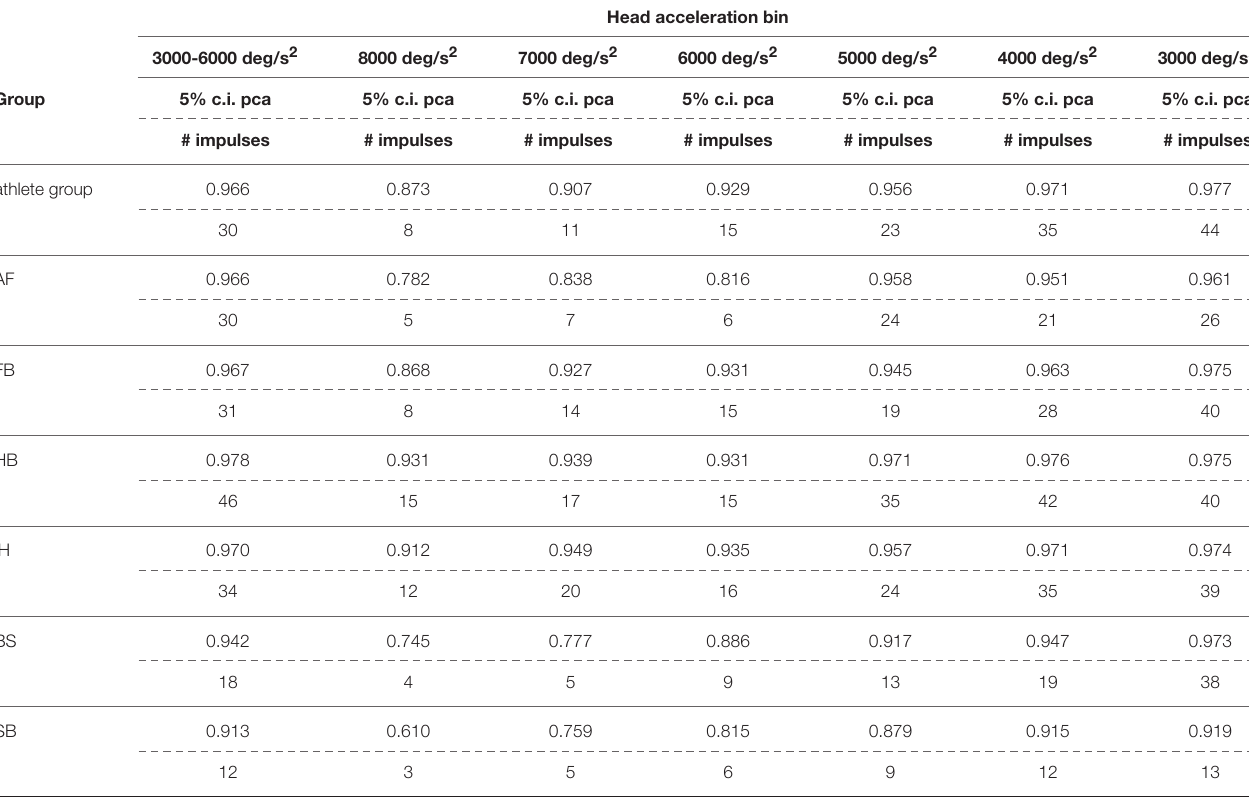
TABLE 6B | Sport specific lower boundary of pca and minimum number of head impulses to identify a deficit—vertical canals.